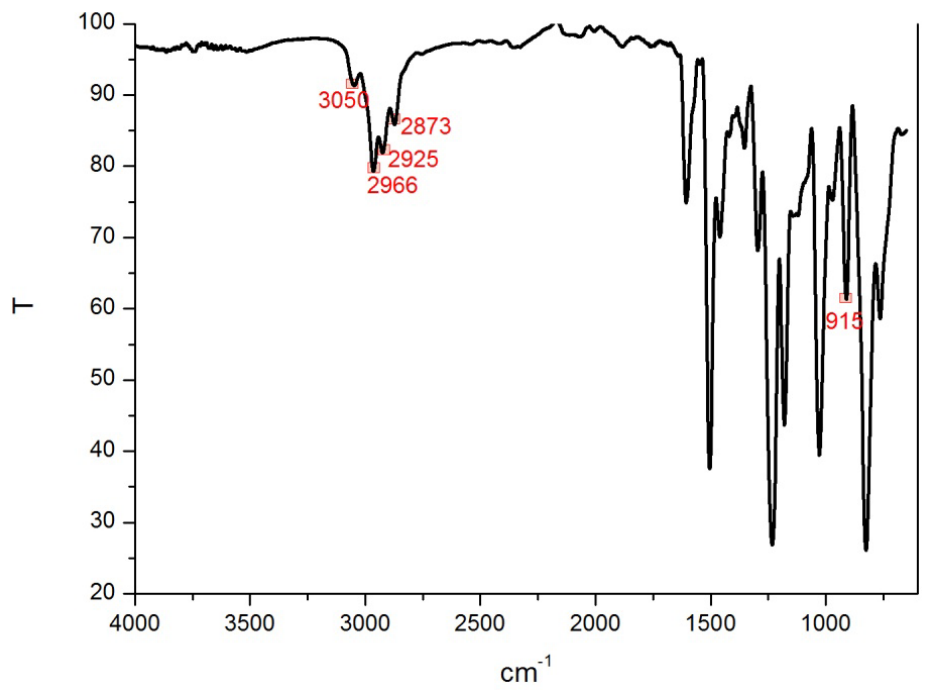
Figure 3. IR spectrum of liquid 828 epoxy resin.